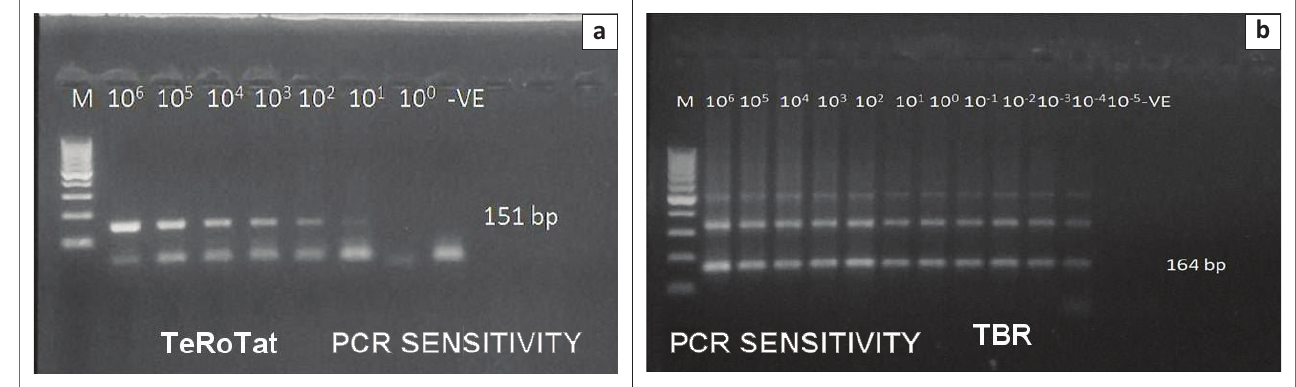
FIG URE 2: Polymerase chain reaction detection limit by conventional polymerase chain reaction. Lane M: 100 base pairs molecular weight Deoxyribonucleic acid marker. Lanes 1–12: different dilutions and -ve: negative control. Trypanosoma brucei 1/2 detects Trypanosoma evansi at lower dilutions (10 -4 parasite/mL) than T. evansi Rode Trypanozoon antigen type 1/2 (10 parasite/mL of blood). (a) TeRoTat; (b)